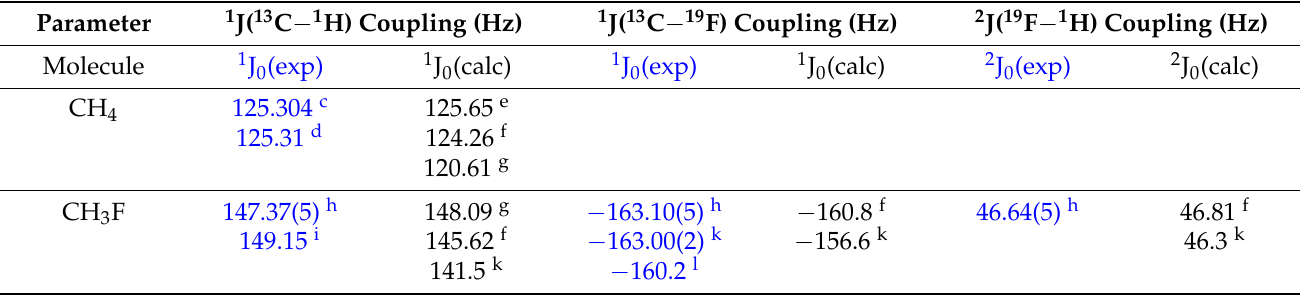
Table 3. Selected indirect spin-spin coupling constants for CH 4-n F n isolated molecules available from gas-phase NMR experiments a and advanced ab initio calculations of quantum chemistry b